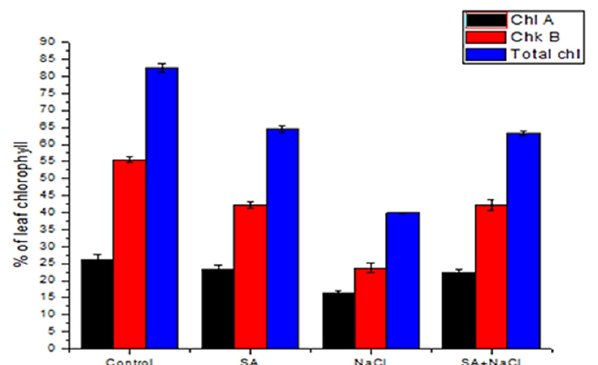
Figure 4. Chlorophyll content: individual and combined effect of salinity and SA on chlorophyll content. X axis-Treatment group; Y axis- Percentage of leaf chlorophyll pigments Values are expressed as mean ± SD, n=3 in each